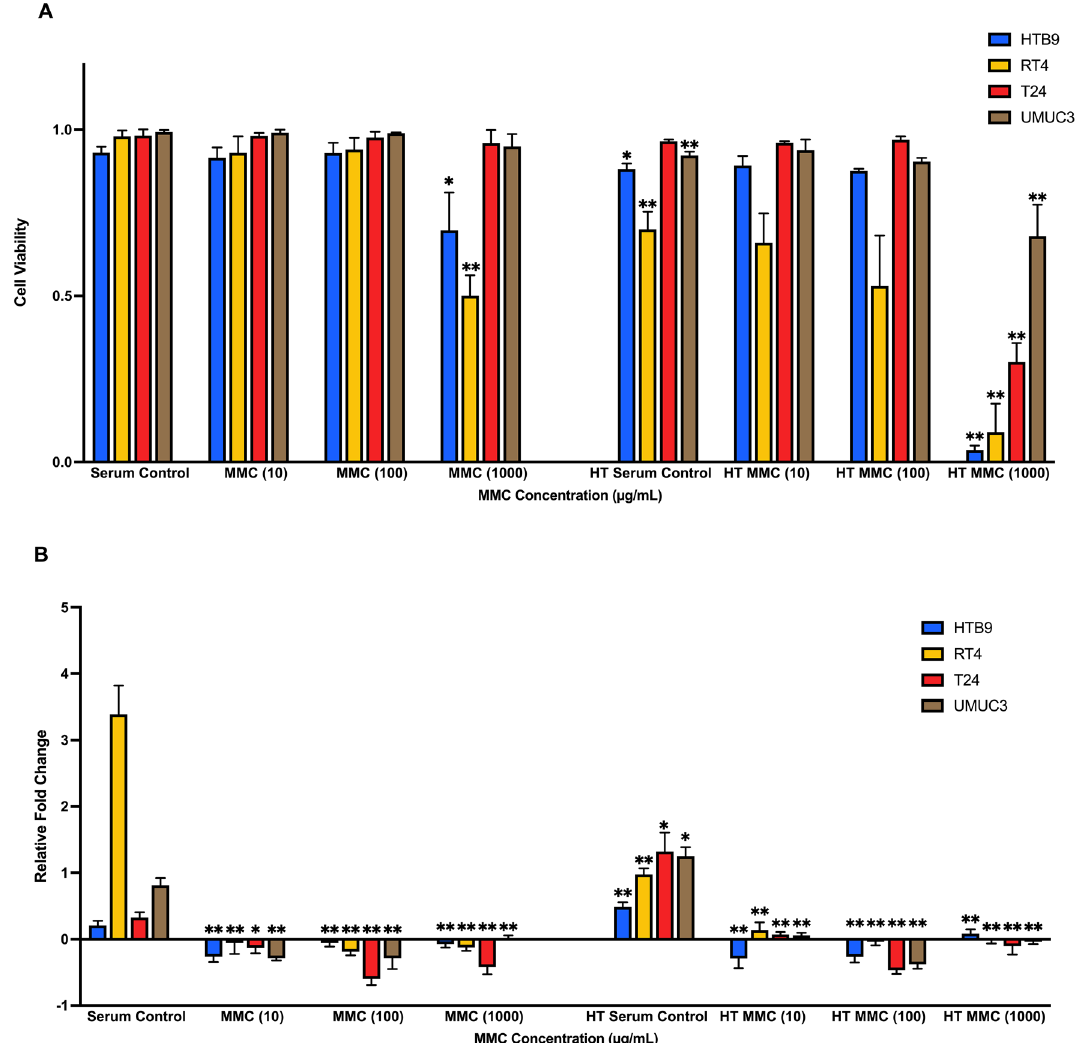
Figure 4. Hyperthermic Mitomycin-C markedly inhibits proliferation and tumour character of CaB cells. (A) Cytotoxicity of MMC was tested on bladder cancer cell lines at different concentration, 10 µg/ml, 100 µg/ml and 1000 µg/ml; at 37 °C and 43 °C. Total cell counts were calculated by trypan blue exclusion assays after drug incubation. Cell viability was evaluated and presented as percentage of living cells. (B) Growth suppression was measured by MTT assays and expressed as relative fold change at end point of 48 h. (C) Adhesion assays were measured by MTT assays and OD reading was proportional to the number of adhered cells. (D) Matrigel invasion abilities were evaluated by crystal violet staining and cell counting. (E) Colonies formation assays were performed by staining the cell clones with crystal violet. Colony with more than 50 cells was counted. Data are presented as the mean ± SD. 37 °C treatments and 43 °C serum control were compared with 37 °C serum control of the same cell line, and 43 °C treatments were compared with 43 °C serum control of the same cell line. *p < 0.05 and **p < 0.01, t test (n = 3, three independent biological replicates were performed for all the